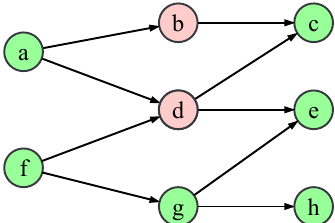
A toy example shows the difference between the influence maximization and our proposed